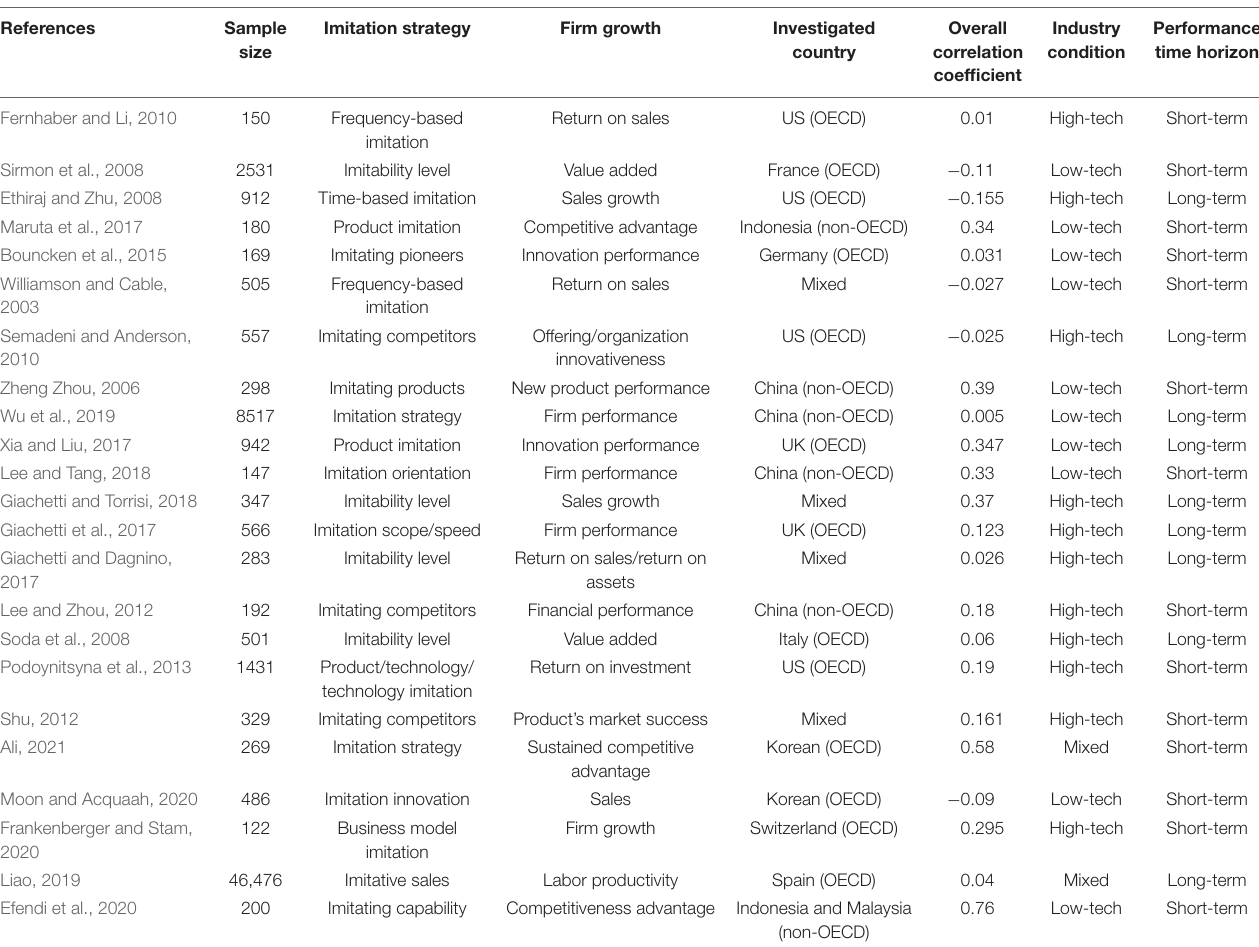
TABLE 1 | Basic information of the collected quantitative